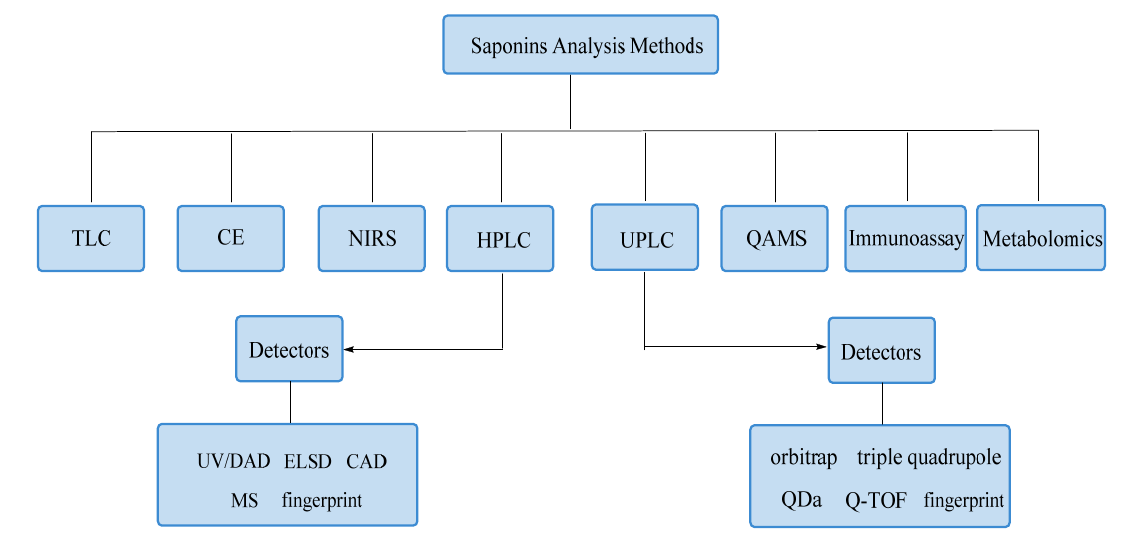
Figure 6. Structural diagram of analytical methods for Saponins.